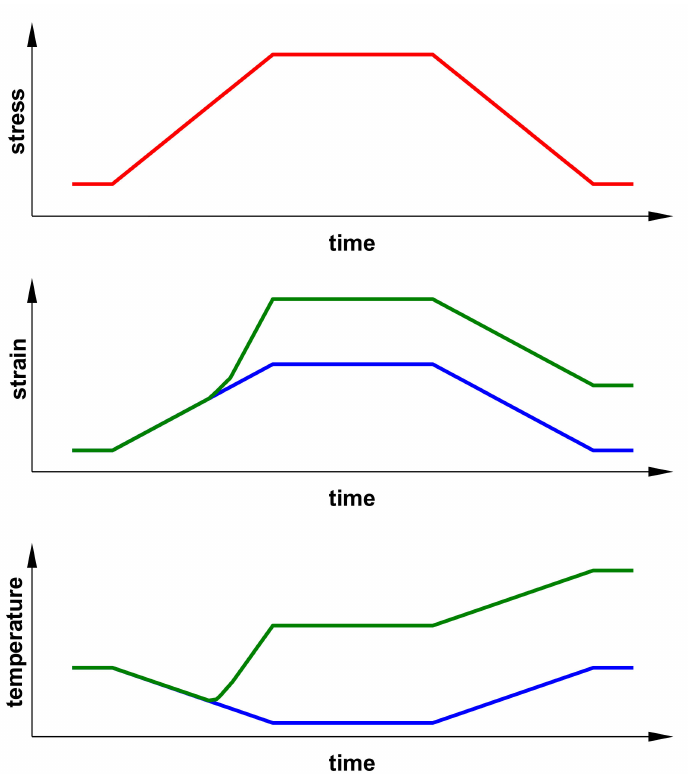
Figure 1. Schematic representation of the change in the course of strain and temperature over time due to trapezoidal load for a material in the elastic state (blue lines) and in an elastic-plastic state (green lines) (on the basis of